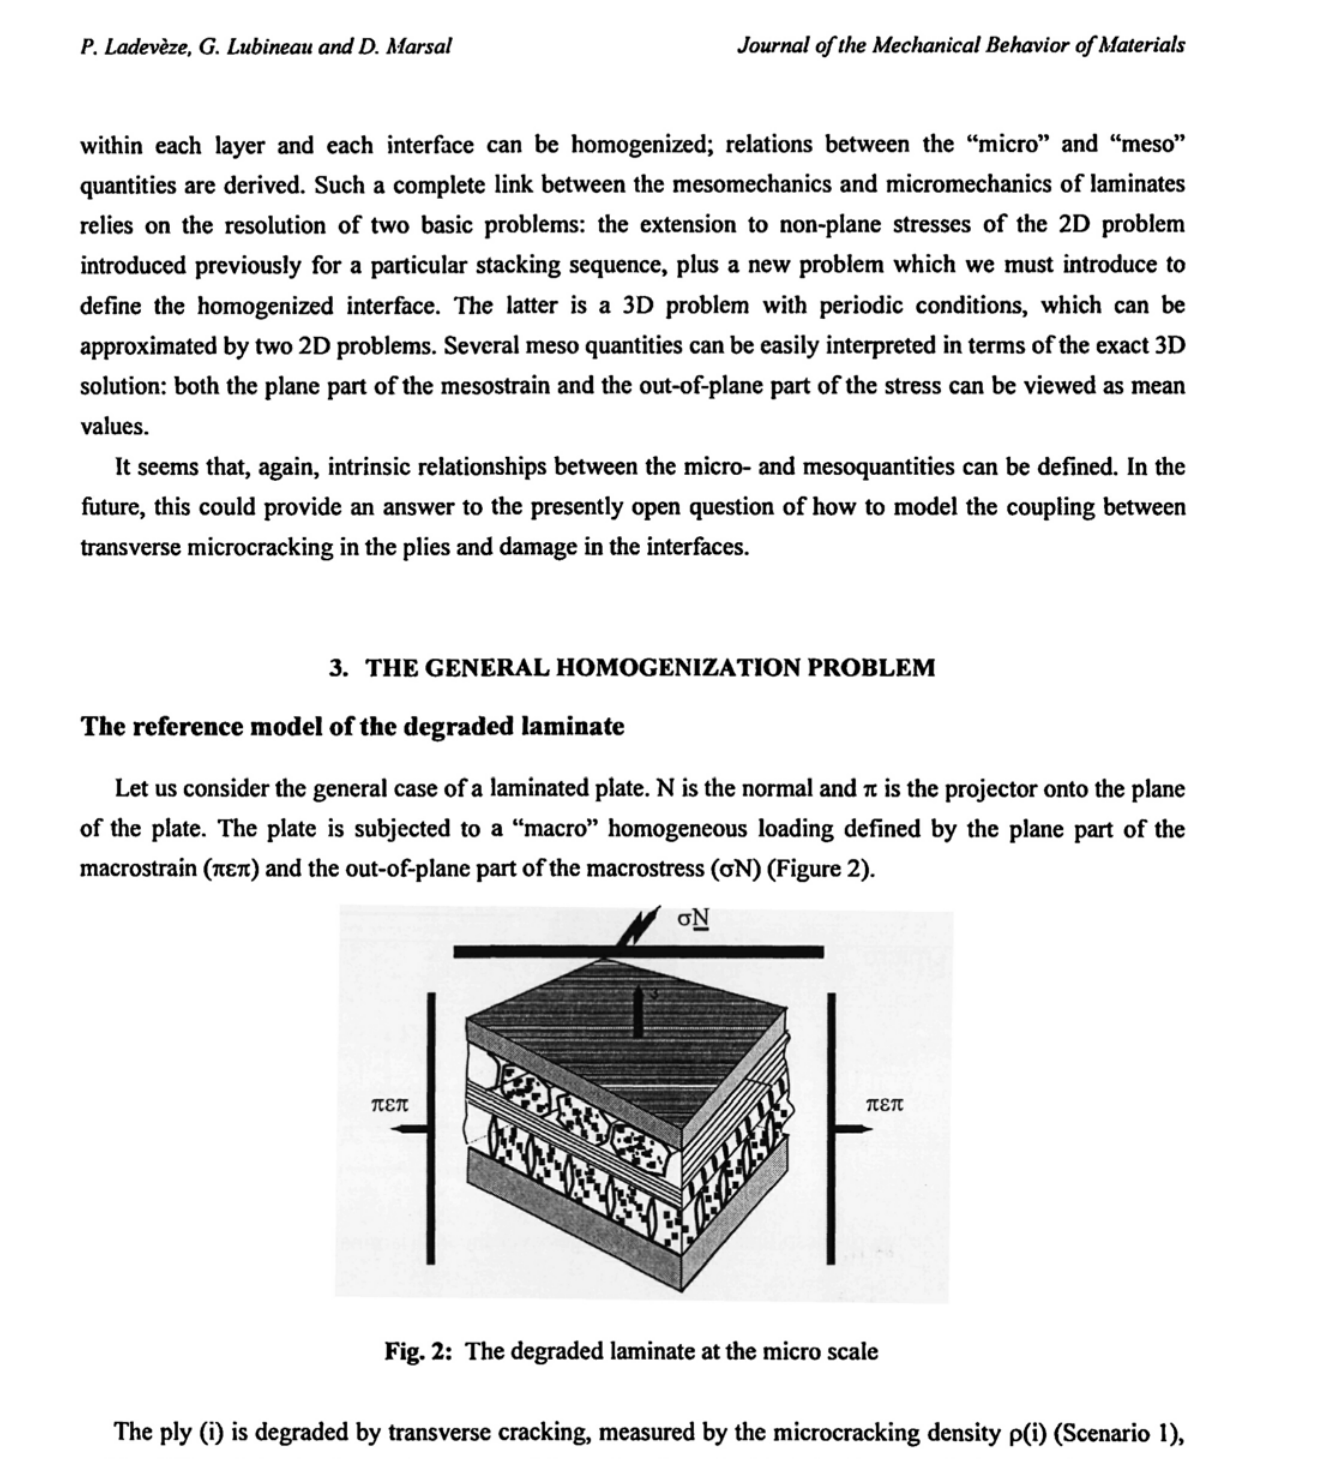
Fig. 2: The degraded laminate at the micro